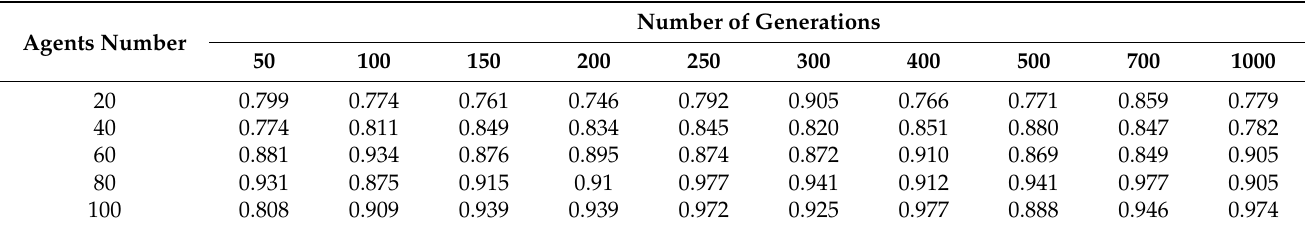
Table 4. NSGA-II without Agents in different Population Sizes and Generation Sizes.